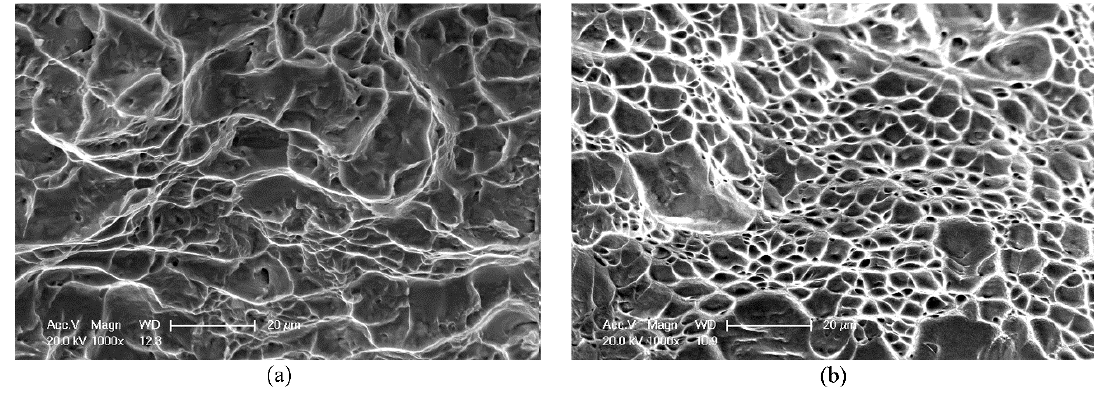
Figure 5. SEM observation of fracture surfaces for samples tested at ( a ) 0.001 s − 1 and ( b ) 1050 s − 1 .